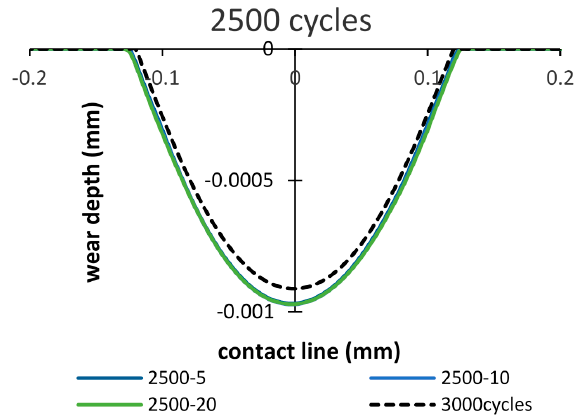
Figure 15. Wear scar after 3000 cycles of the debris layer model: importing time = 2500 cycles and layer thickness = 5 µm, 10 µm, 20 µm.